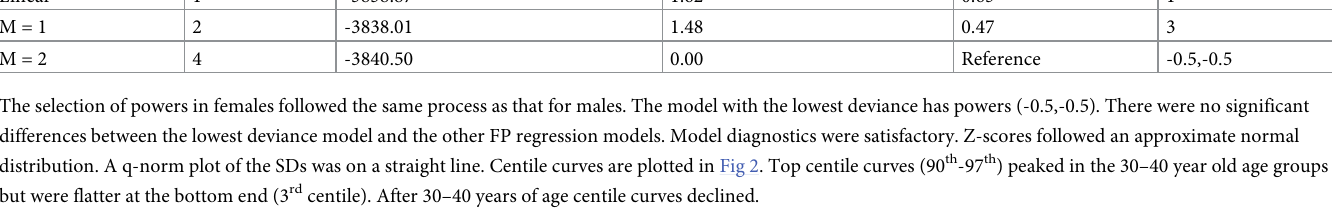
Table 3. Fractional polynomial regression in females.